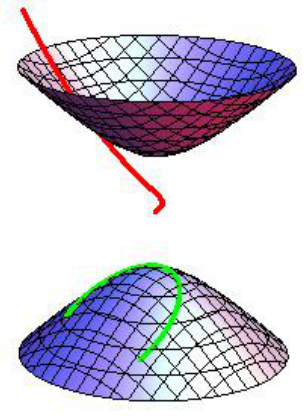
Figure 6. r (red) and ¯ r (green) on H 2